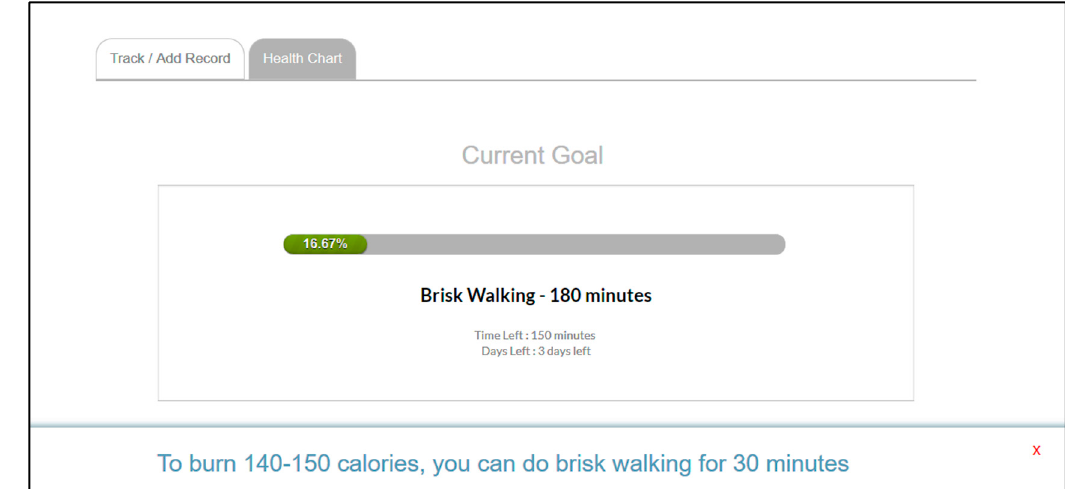
Figure 3. A performance bar showing the progress of the physical activity completed by a user.